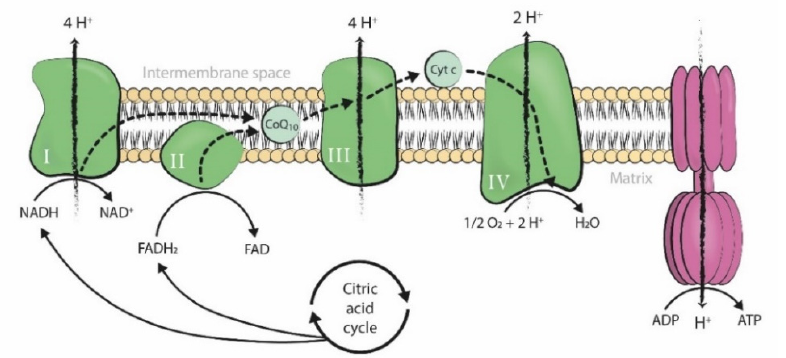
Figure 1. Mitochondrial respiratory chain (Complexes I, II, III, and IV; CoQ10, and cytochrome c)